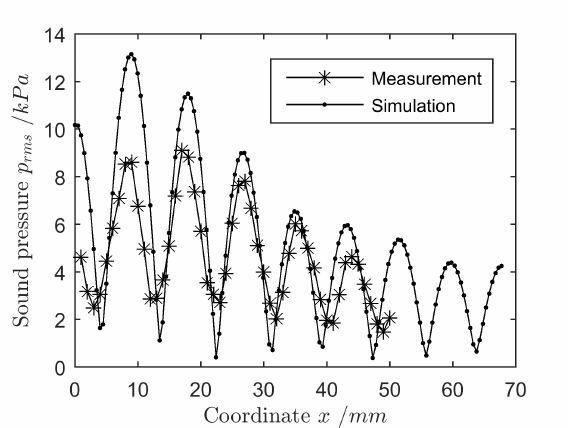
Figure 17. Sound pressure level (SPL) along the rotational axis of a standing wave system with concave reflector at a distance of L = 4 λ ; f = 21.4 kHz; ˆ x = 19 µ